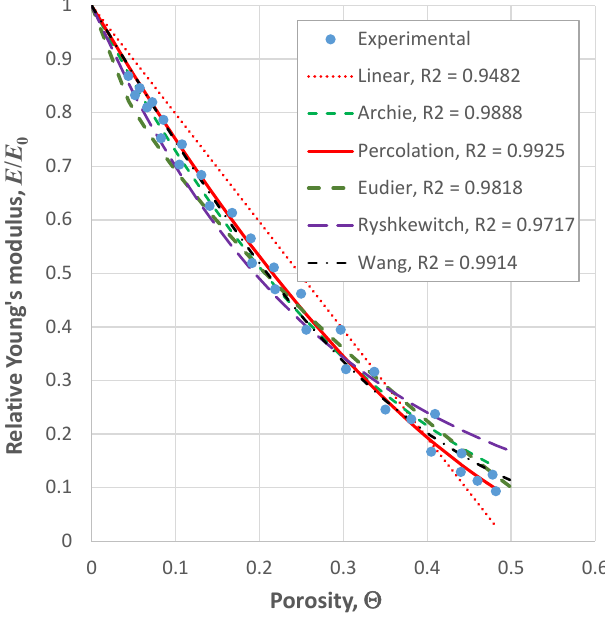
Figure 2. Experimental values of relative Young’s modulus vs. porosity [44] and fitting with the linear law (Dewye), Archie’s law (Bal’shin), percolation law, Eudier’s law, Ryshkewitch’s law and Wang’s law.